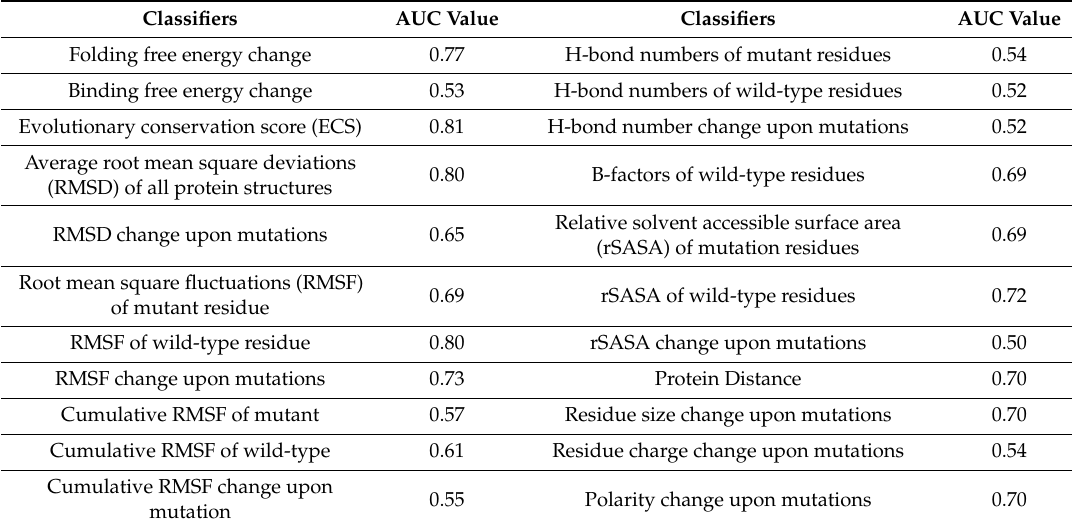
Table 1. Area under the curve (AUC) value of receiver operating characteristics (ROC). Twenty-two physicochemical characteristics and thermodynamics parameters being investigated. Protein structures being analyzed: Wild-type 1; non-pathogenic mutations 41; pathogenic mutations